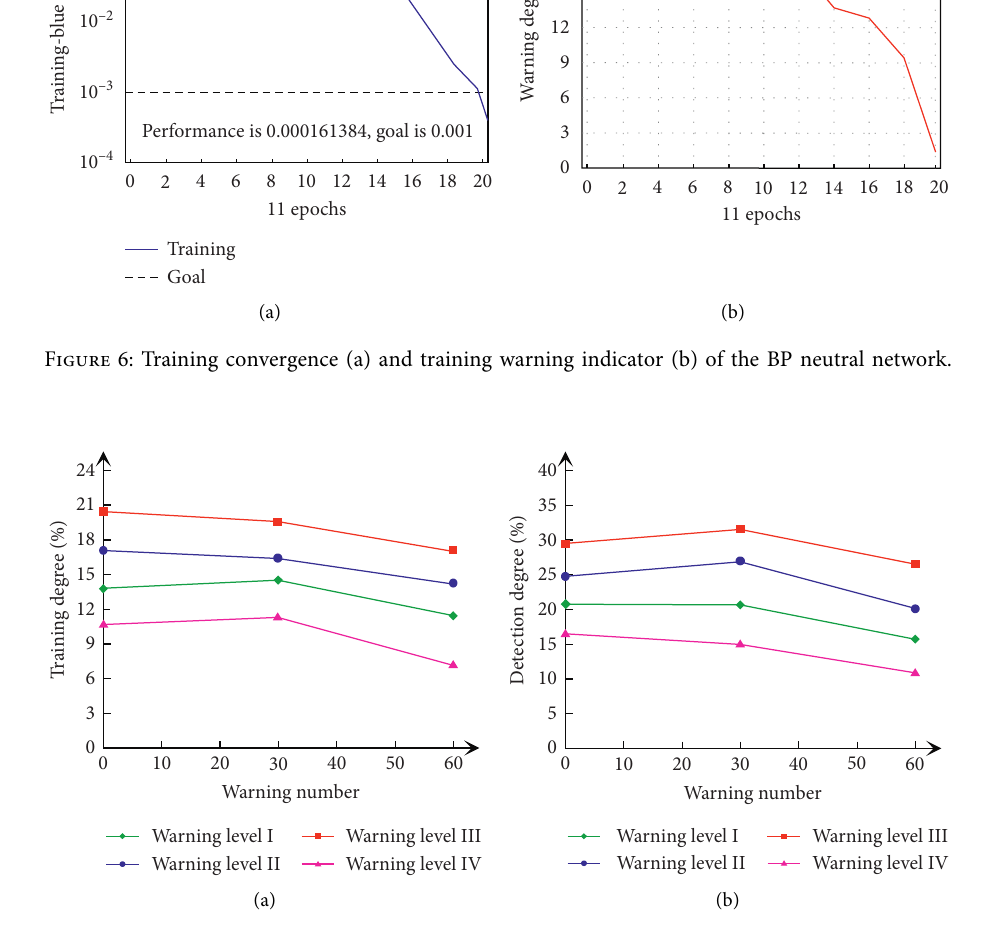
Figure 7: Training (a) and detection (b) results of the risk warning model based on the BP neural network.